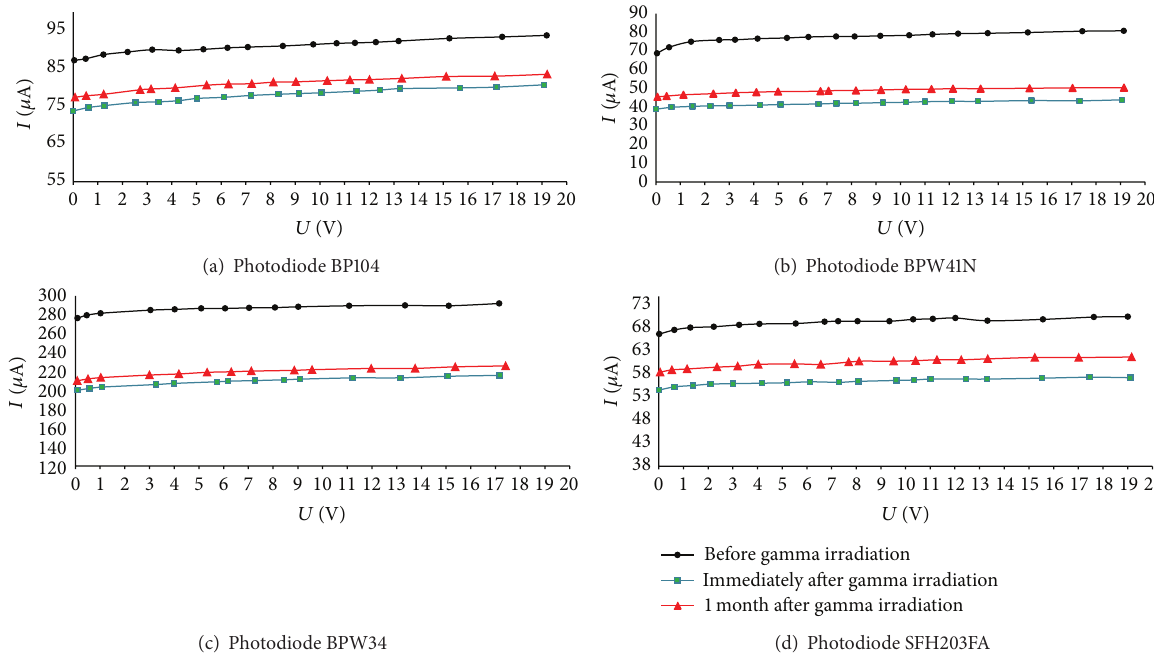
Figure 3: I - V characteristics of the reverse-biased photodiodes before and after gamma irradiation.